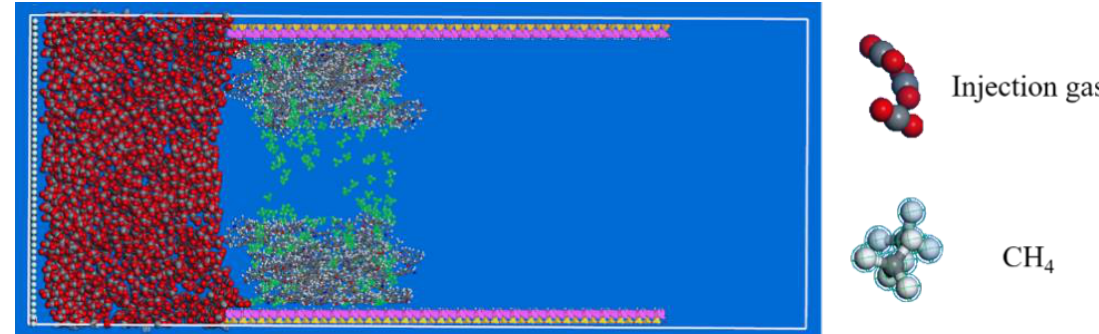
Figure 4. The physical model for the shale gas displacement process.